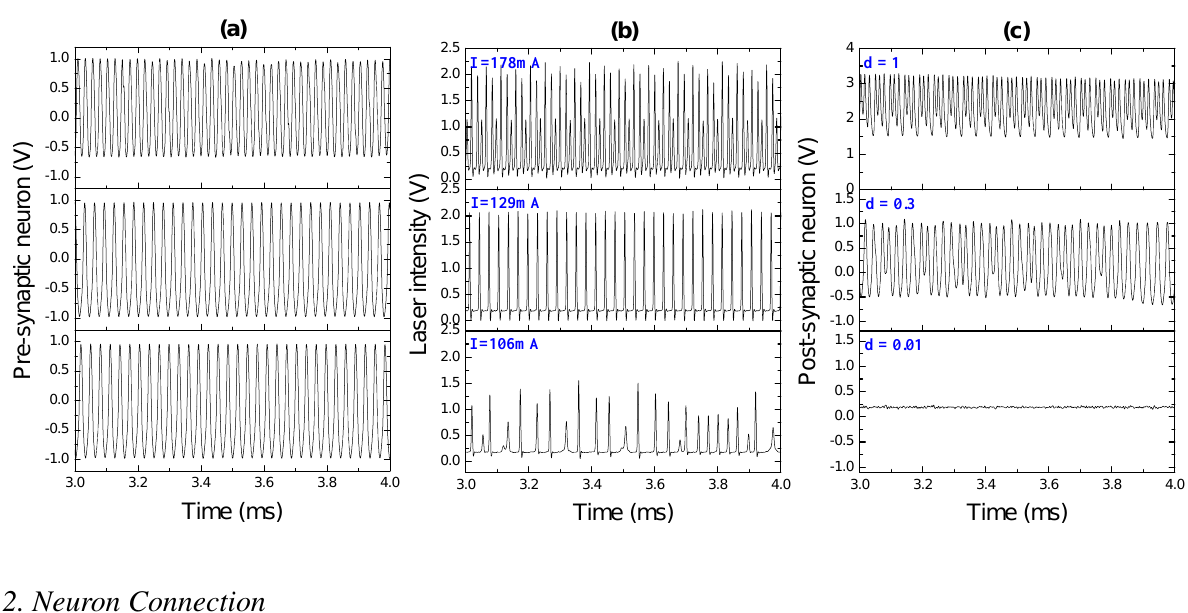
Figure 6. Time series of the ( a ) pre-synaptic neuron, ( b ) laser and ( c ) post-synaptic neuron. The laser response in (b) displays the 2:3 (upper trace) and 1:1 (middle trace) frequency-locking and chaotic (lower trace) regimes, while the post-synaptic neuron response in (c) exhibits the 2:3 (upper trace), unlocked (middle trace) and silence (lower trace)